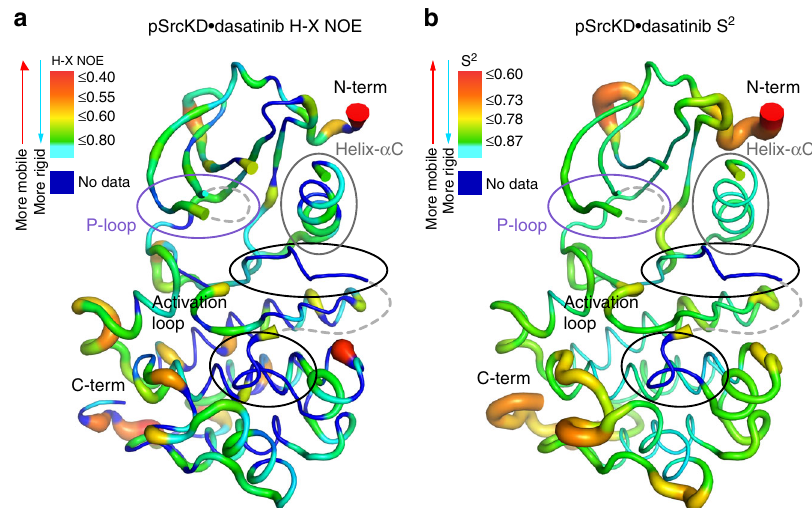
Fig. 7 Fast backbone dynamics are present at distal sites of pSrcKD (cid:129) dasatinib. a The H-X NOE ratio which indicates motions on the pico- to nanosecond timescale are mapped to the structure of SrcKD (cid:129) dasatinib (PDB: 3G5D). b S 2 order parameters predicted from NMR chemical shifts report on the amplitude of displacement of the backbone amide bond vector from its mean position on the pico- to nanosecond dynamics timescale (fast internal motions). The H-X NOE ratio and S 2 values are indicative of fl exible and rigid backbone regions. Both show similar regions of fl exibility and rigidity. The thickness of the backbone and the corresponding color shown in the key re fl ects the extent of fl exibility/rigidity. Here dasatinib is omitted from the structure for